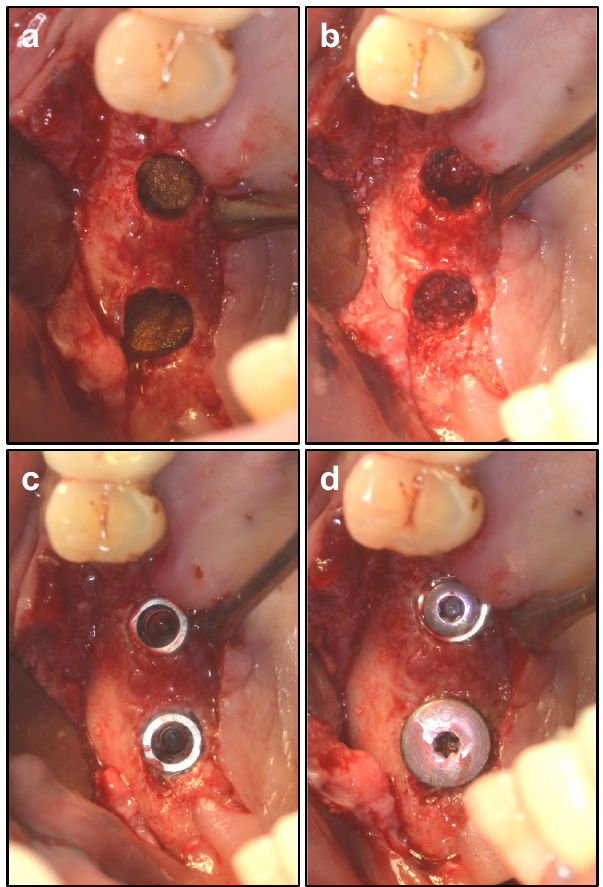
Figure 4. Guided bone regeneration (GBR) and inserting implants. ( a ) placing antibacterial Gelatamp into the sinus. ( b ) filling the space with Bio-Oss. ( c ) inserting the Implant. ( d ) placing a cover screw or a large-diameter healing